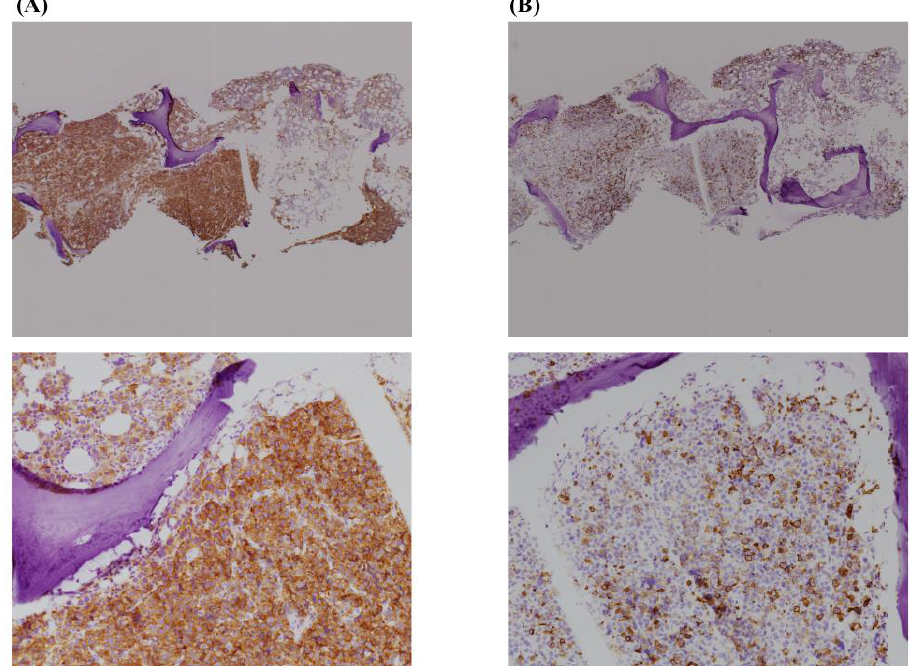
Figure 3. Immunohistochemical staining of bone marrow biopsy. ( A ) Nearly all the nucleated cells were positive for CD71. (×40, ×100) ( B ) Cells were weakly positive for Glycophorin A (×40, ×100).